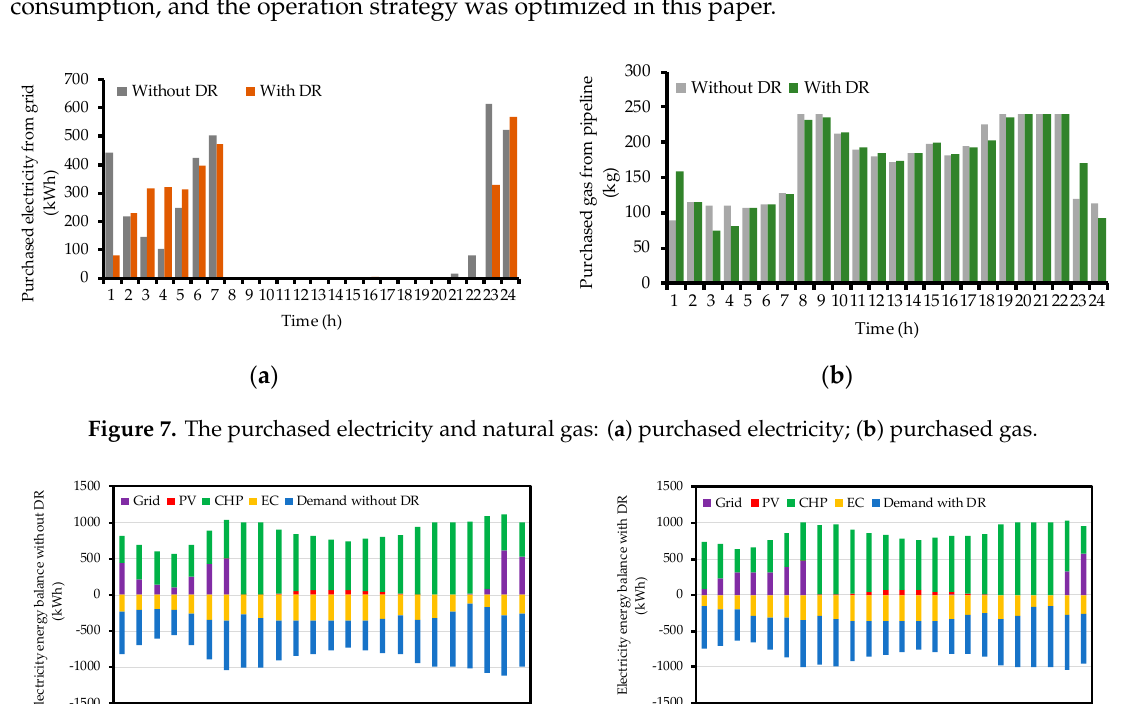
( b ) Figure 9. Natural gas distribution ratio: ( a ) without DR; ( b ) with DR. The purchased natural gas from the pipeline is presented in Figure 7b, and the distribution ratios for the CHP unit and the GB are illustrated in Figure 9 for each case at each hour. The purchased gas for both cases was distinct in some periods, owing to the DR program. The amount of gas needed in Case 1 was more than in Case 2 during 3:00–4:00, and more natural gas was purchased in Case 2 at 23:00, as described in Figure 7b. Hence, the scheduling results for natural gas and grid electricity were complementary at these periods because more natural gas are purchased and less electricity were needed when the RTP tariffs were high at some periods, and vice versa. From Figure